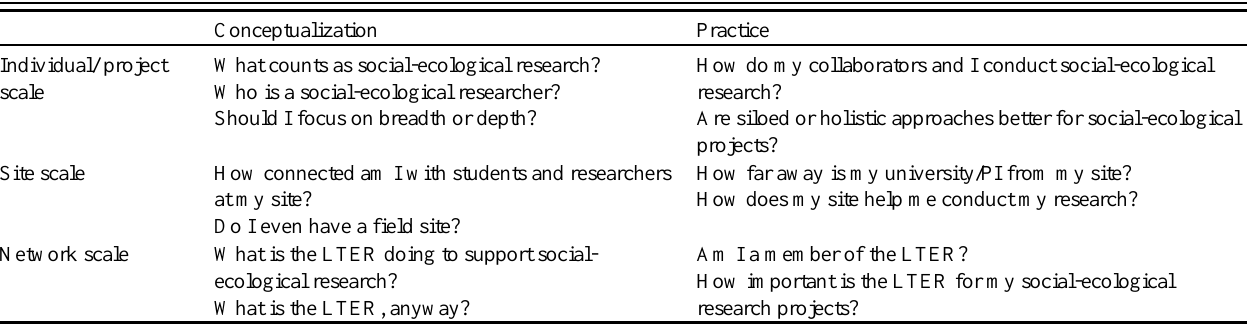
Table 1 . Examples of the types of challenges that Long Term Ecological Research (LTER) graduate students may experience with the conceptualization and practice of social-ecological research at the individual, site, and network scales.